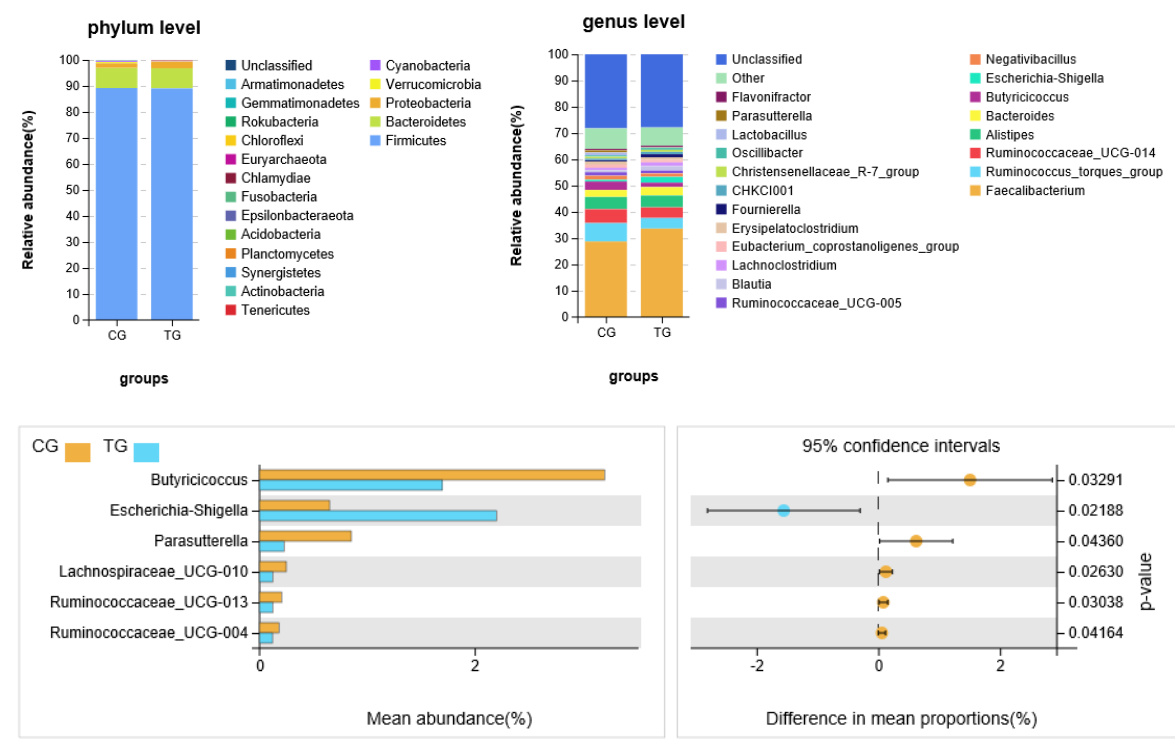
Figure 4. Accumulation map of broiler cecal microorganism abundance at the ( A ) phylum and ( B ) genus level. ( C ) Six bacteria with significant difference in relative abundance between two groups.